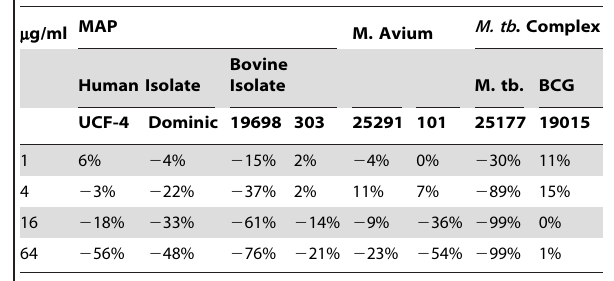
Table 9. Retinoic Acid.